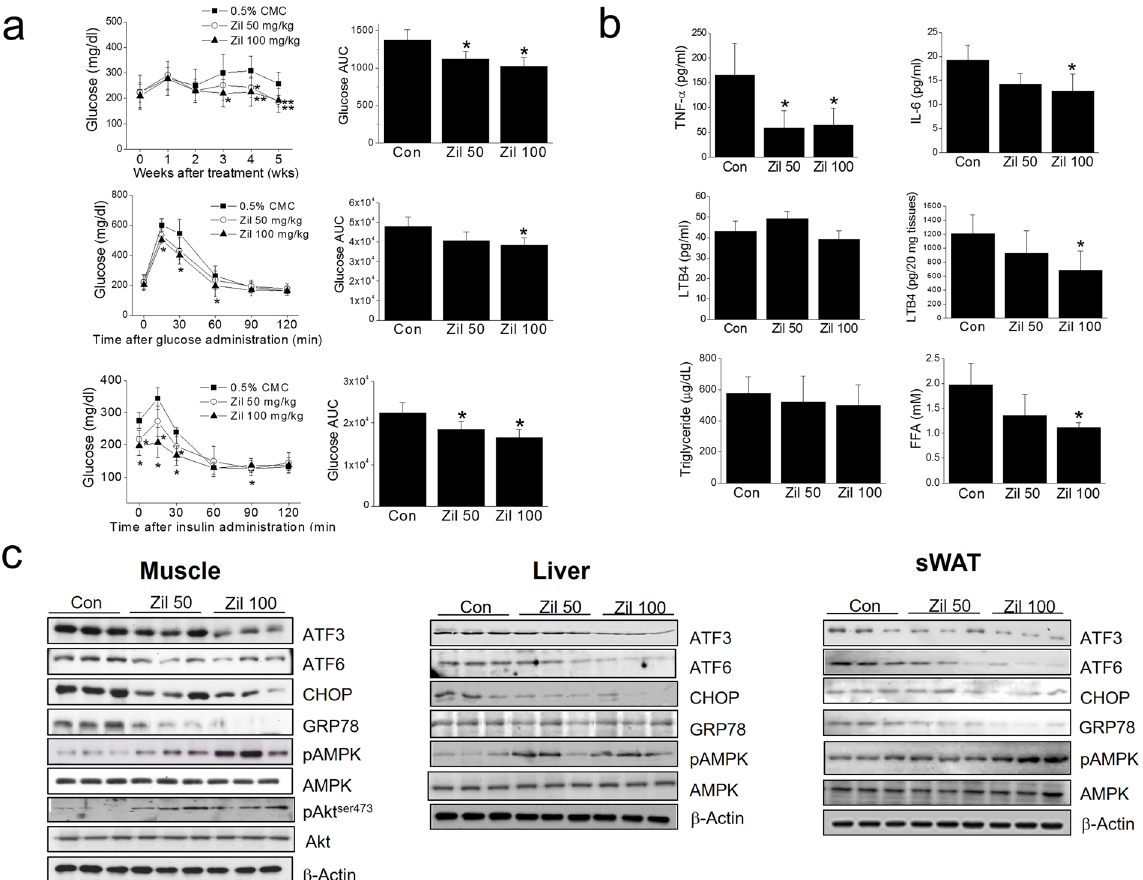
Figure 9. In vivo effects of zileuton in ob/ob mice. Zileuton (50 or 100 mg/kg, n = 10 each group) was orally administrated to ob/ob mice once daily for 5 weeks; plasma glucose concentrations were determined weekly from tail veins ( a , top). At the end of the experiment, oral glucose tolerance ( a , middle) and insulin tolerance testings ( a , bottom) were conducted, and plasma glucose AUC was calculated using OriginPro 6.1 software. The plasma levels of pro-inflammatory cytokines, LTB4, FFA and triglyceride were measured by ELISA kits ( b ). Muscle LTB4 was determined by ELISA kits ( b ). The expression levels of ER stress markers, and AMPK and Akt phosphorylation levels in skeletal muscles, liver and adipose tissues were determined by western blotting ( c ). * P < 0.05, ** P < 0.01 vs . non-treated